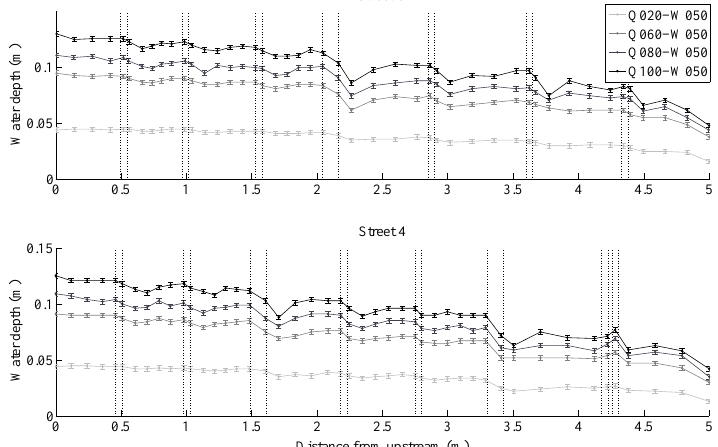
Figure 4. Observed water depths in streets C and 4 for inflow discharges varying between 20 and 100m 3 s − 1 . Dashed vertical lines indicate the intersections.